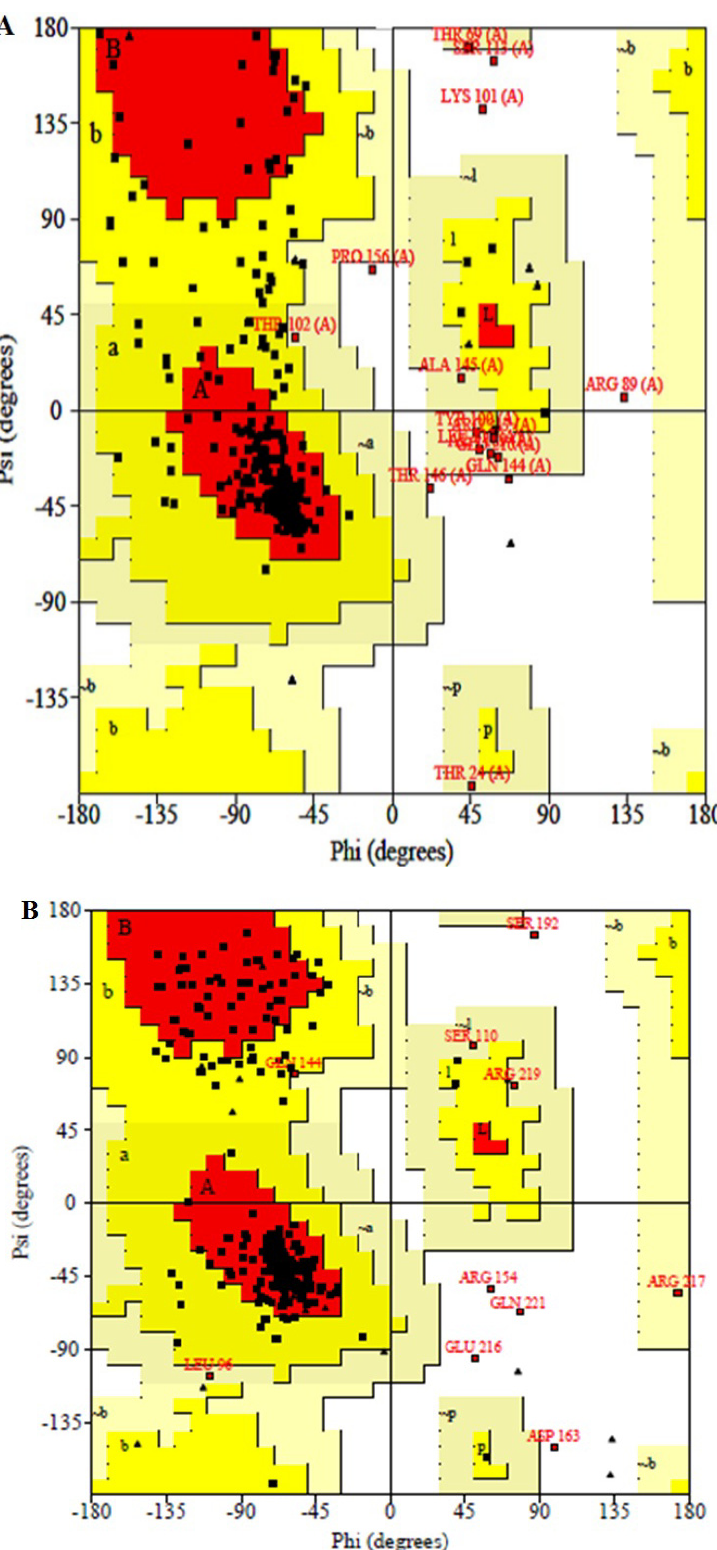
Figure 8. Ramachandran plot of the 3D structure of DehD evaluated by the PROCHECK program. ( A ) Model before refinement. ( B ) Model after MD simulation. The most favored and favored region are indicated with red and yellow colors, respectively. The generously allowed region is shown in pale yellow and the disallowed region is in white